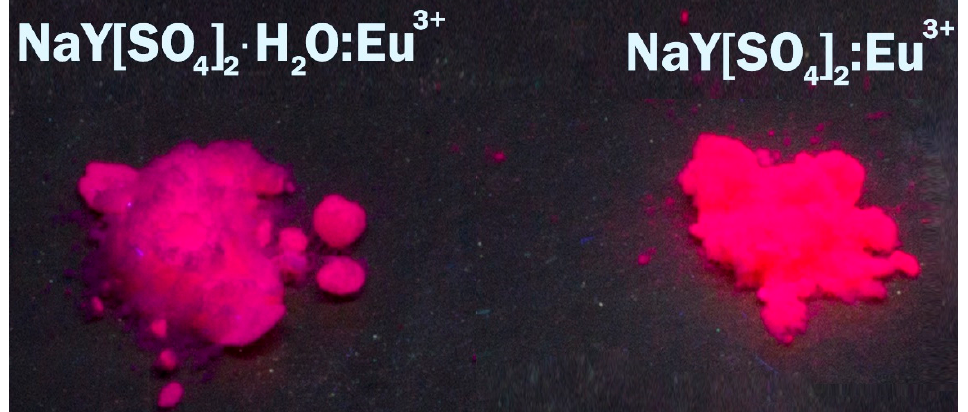
Figure 11. NaY[SO 4 ] 2 ∙ H 2 O:Eu 3+ ( left ) and NaY[SO 4 ] 2 :Eu 3+ ( right ) under UV irradiation ( λ exc = 254 nm).